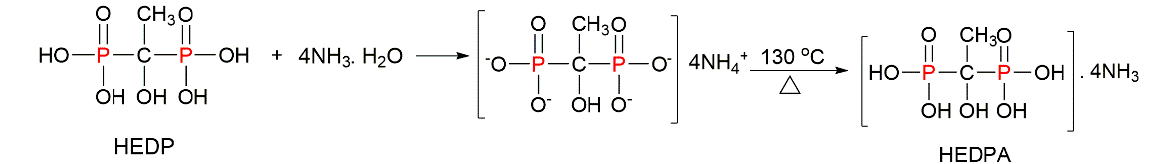
Figure 11. A synthetic route for the preparation of ammonium salt of HEDPA [77].